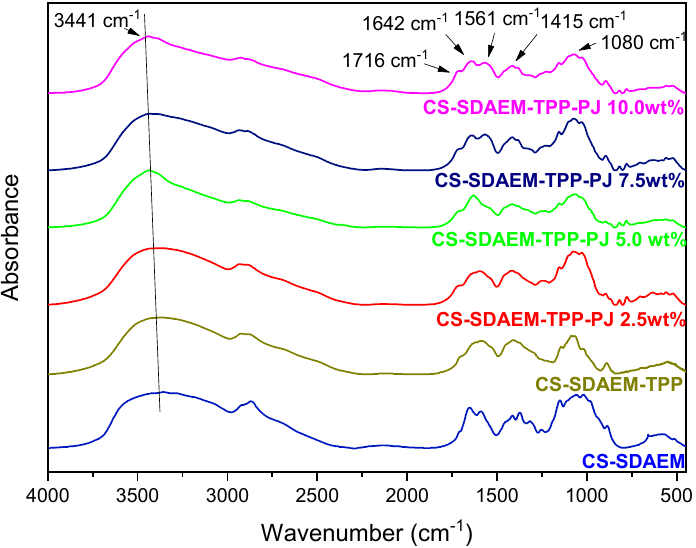
Figure 7. FTIR spectra of CS-SDAEM nanoparticles 2.5, 5.0, 7.5 and 10.0 wt% containing PJ.